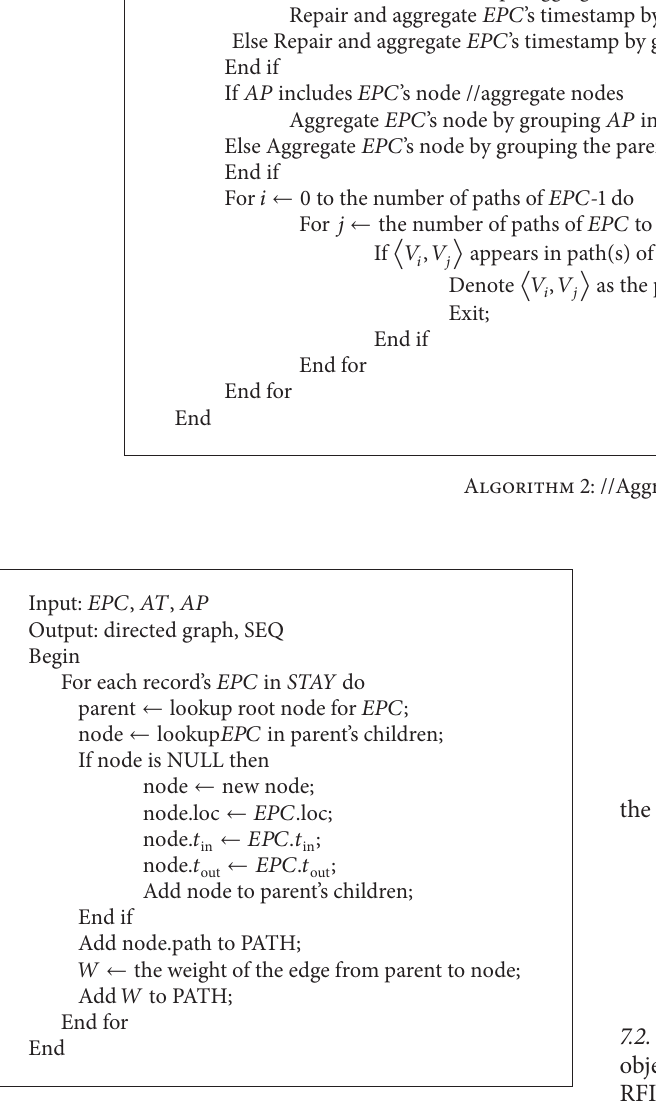
Algorithm 3: Build directed